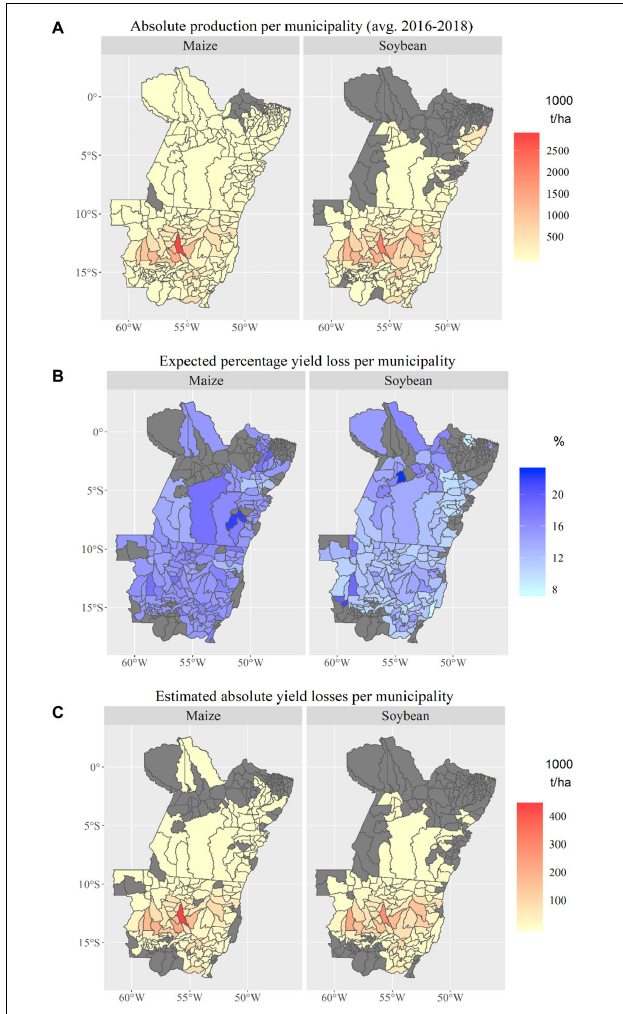
FIGURE 10 | (A) Absolute maize and soybean production in municipalities of Mato Grosso and Pará, Brazil; (B) expected maize and soybean yield losses (%) due to the most common P&A in the study area; and (C) absolute maize and soybean production losses per municipality in Mato Grosso and Pará,